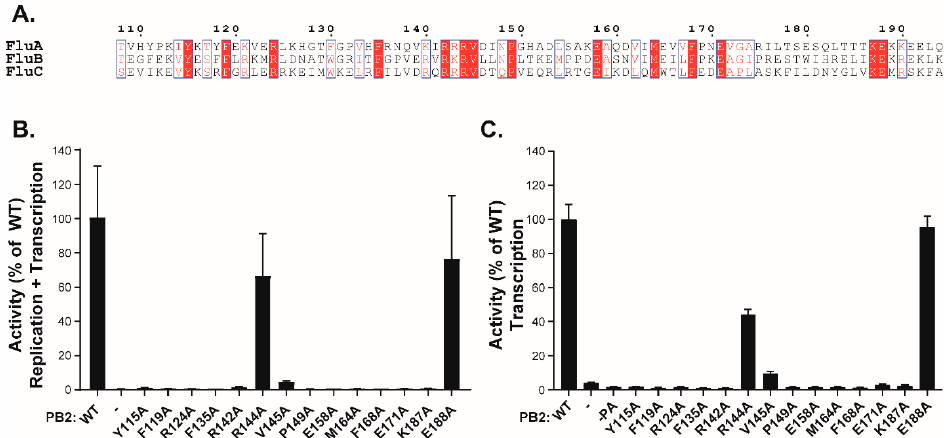
Figure 6. Transcription/replication activity of FluPol with PB2 mutants. ( A ) Multi-alignment with the PB2 domains (residues 108 to 194) of influenza A, B, and C viruses made with ESPript [30]. Strictly conserved residues are white on a red background, and partially conserved residues are red. ( B ) Plasmids expressing NP, PB1, PA, and wild type or PB2 mutants were cotransfected in 293T cells together with the reporter plasmid WSN-NA-firefly luciferase, allowing the quantification of the polymerase activity. In panel ( C ), the same procedure than in ( B ) was used, except that the PA C95A mutant deficient in replicase activity [15] was used instead of the wt PA subunit. Data are mean ± n = four technical replicates representative of two independent